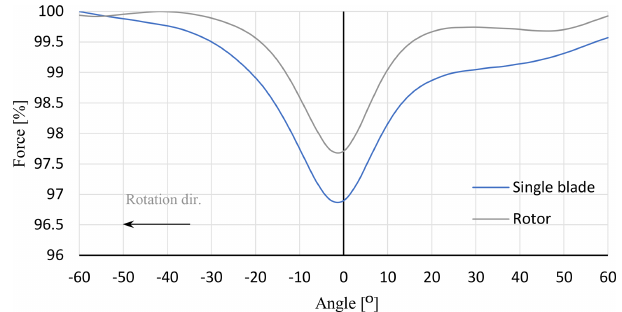
Figure 8. Single blade and rotor thrust for one-third rotation.